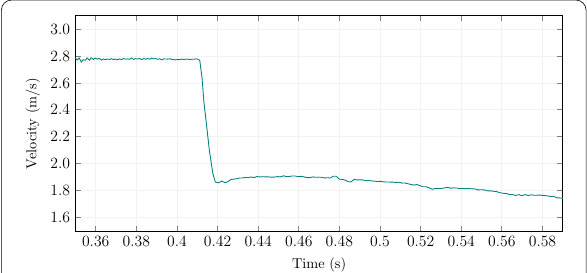
Fig. 7 The impactor’s velocity calculated from acquired